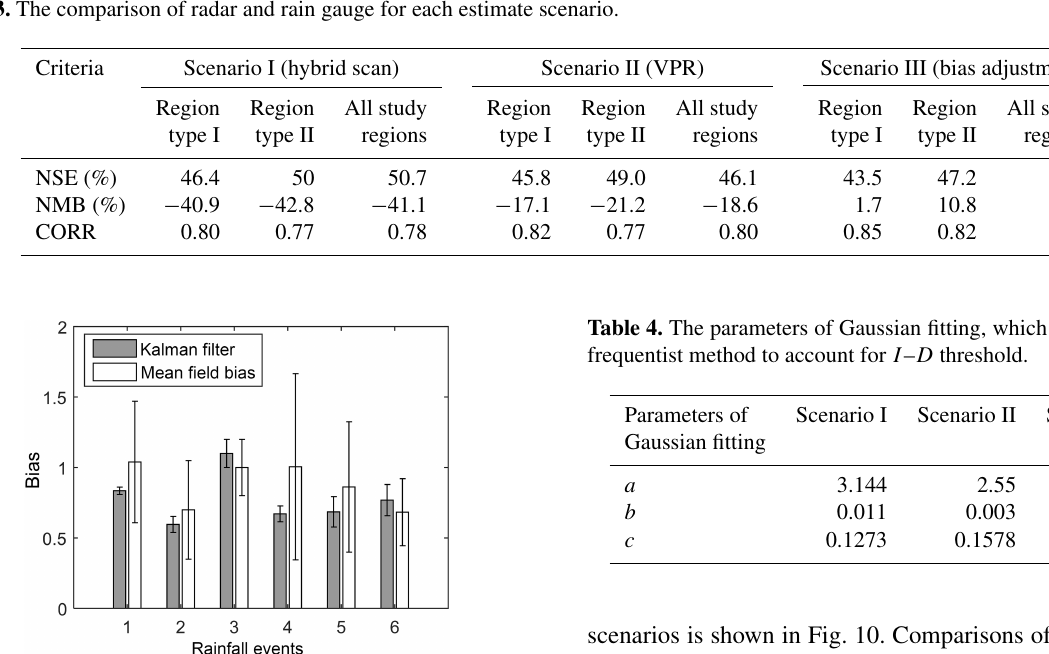
Figure 8. Scatter plots of radar and rain gauge event–rainfall accumulations. (a) Scenario 1: radar estimate from hybrid scan. (b) Scenario 2: radar estimate from hybrid scan and VPR. (c) Scenario 3: radar estimate through the hybrid scan, VPR and bias correction. Table 3. The comparison of radar and rain gauge for each estimate scenario.